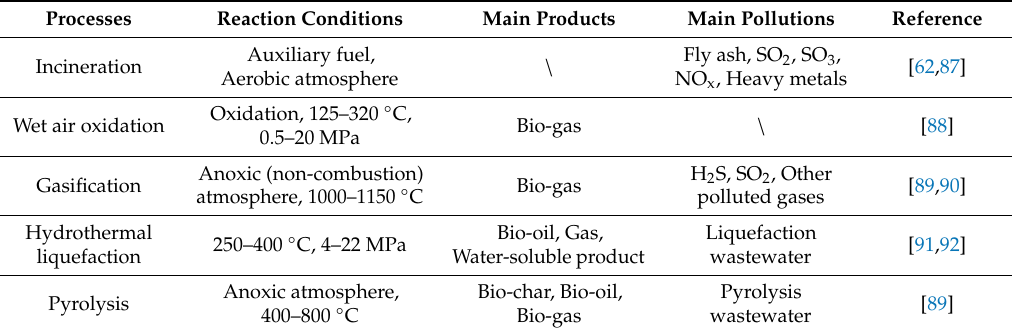
Table 4. Comparison of several thermochemical